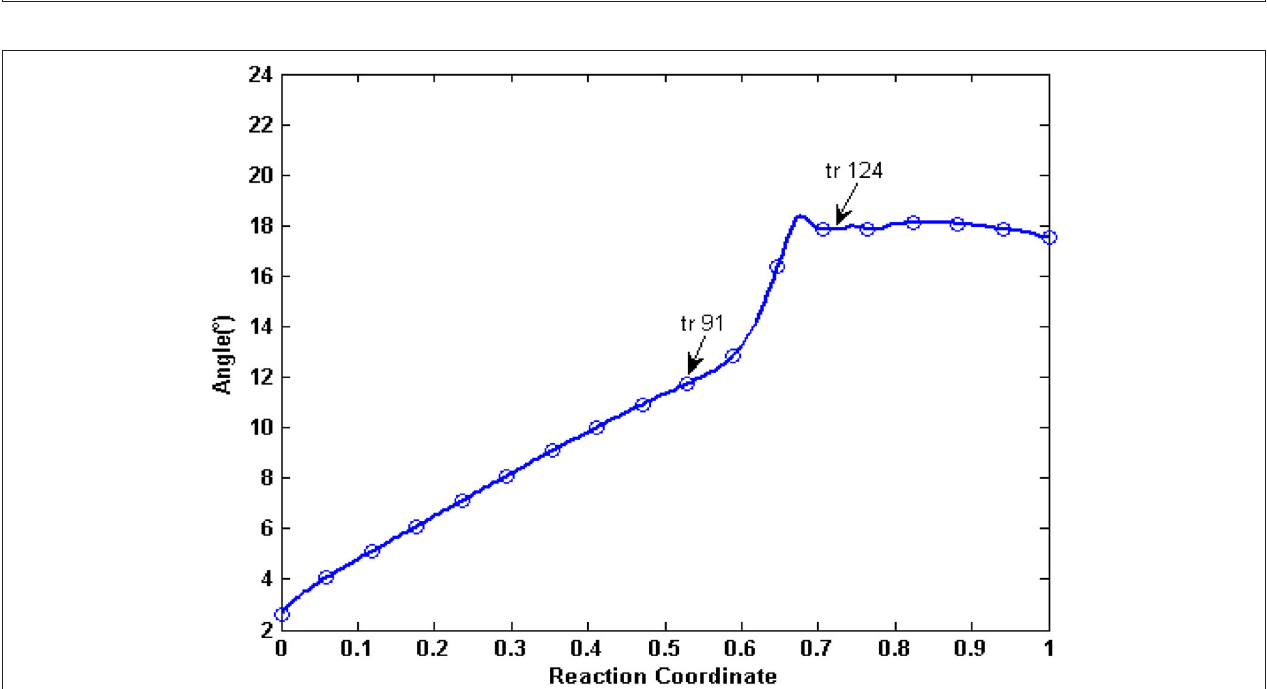
FIGURE 7 | The angle changes of the two lines of PA L413-PA K536 and PB E1059-PB K1181. Arrows represent conformation 91 and conformation 124, respectively.